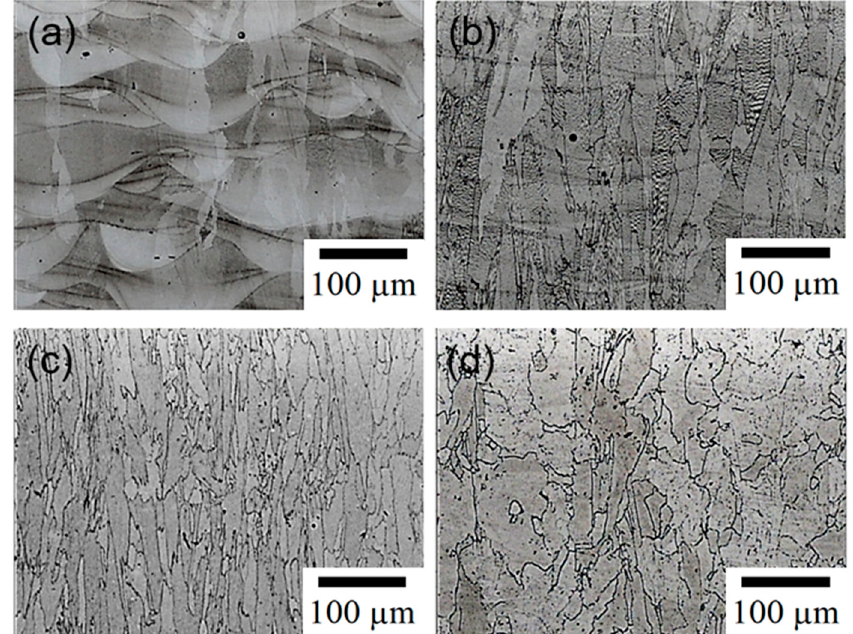
Figure 5. Microstructures of ( a ) AS, ( b ) A, ( c ) SA, and ( d ) HSA. (AS: as-SLM; A: double aging treatment (720 °C for 8 h, then furnace cooling at 55 °C/h to 620 °C, maintaining 620 °C for 8 h, finally air cooling); SA: solid solution treatment (980 °C for 1 h, then water cooling) followed by A; HSA: homogenization treatment (1080 °C for 1.5 h, then air cooling) followed by SA.).